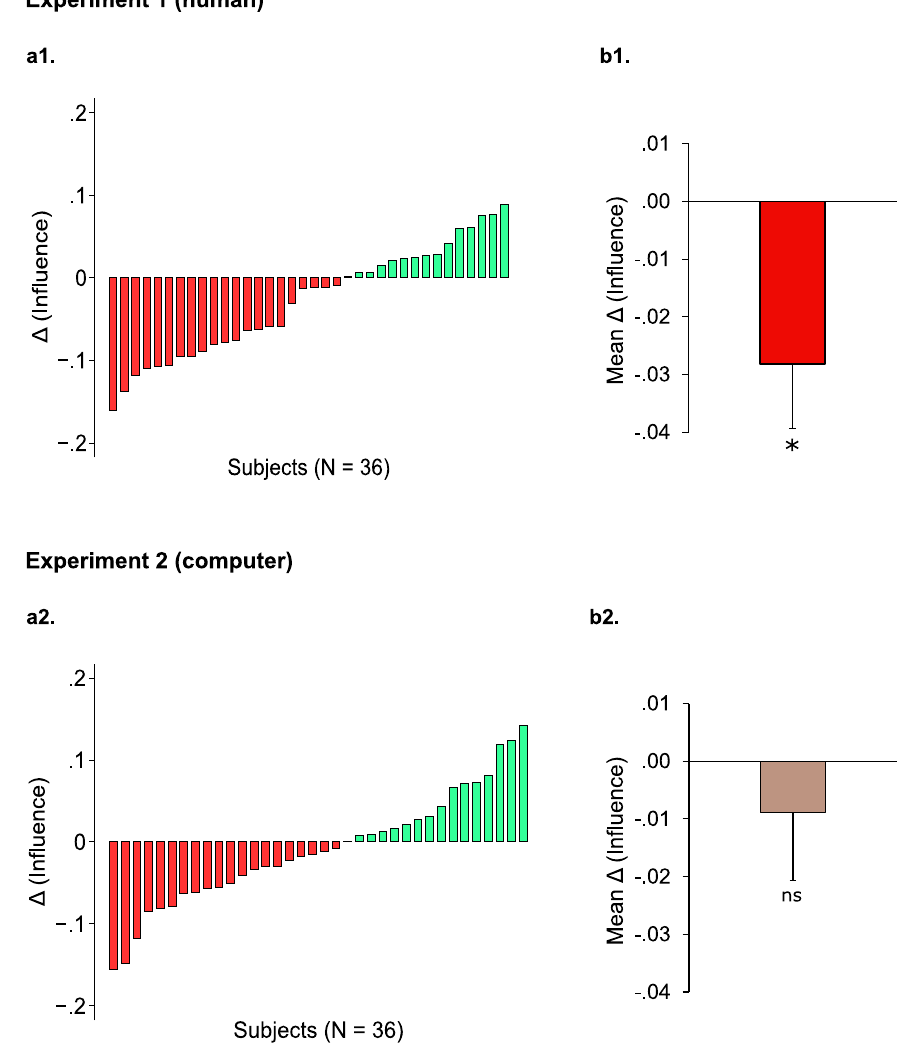
Figure 5. Effect of Final block in the Indirect reciprocity task in Experiment 1 ( a1 , b1 ) and Experiment 2 ( a2 , b2 ). ( a1 , a2) Δ (Influence) in the Final block, computed as mean influence in the Final block minus mean influence in the previous main block of the Indirect reciprocity task, plotted across participants. Negative values (in red) represent participants who decreased the amount of advice taken from the passive agent in the Final block, while positive values (in green) represent individuals who increased their level of susceptibility towards the passive agent in the Final block. ( b1 , b2) Mean Δ (Influence) in the Final block in Experiment 1 and Experiment 2. Error bars represent between-subject standard error of the mean. * p < 0.05, ns: not significant. Effect of block in Mixed-effect